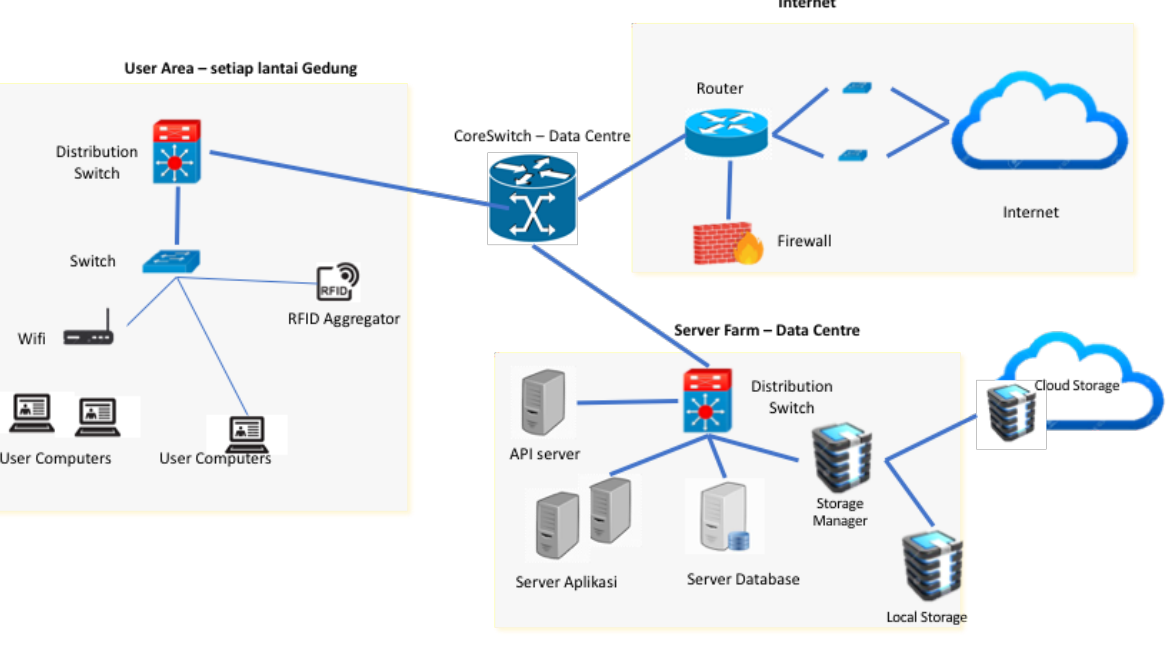
Figure 14. Network Topology Target